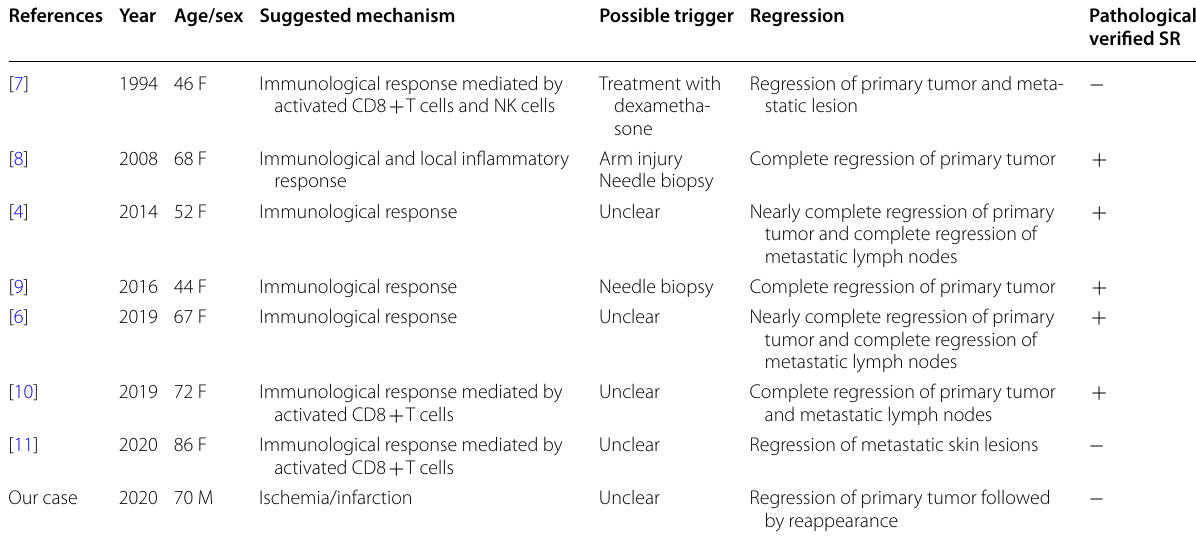
Table 1 Reported cases of spontaneous regression of breast cancer References Year Age/sex Suggested